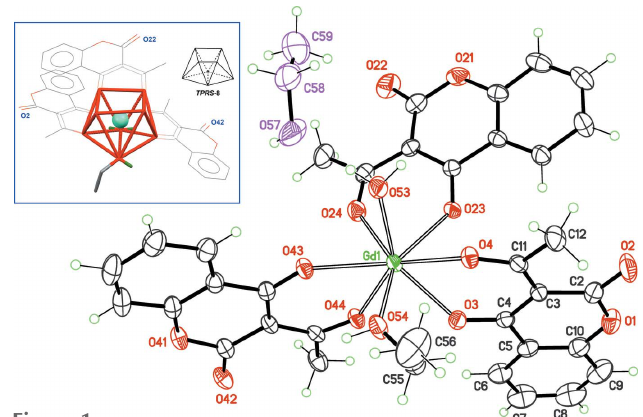
Figure 1 Structure of the title compound, with displacement ellipsoids for non-H atoms at the 30% probability level. The inset shows the Gd III coordination polyhedron (red capped sticks), which is compared with the idealized TPRS-8 polyhedron (IUPAC, 2005).